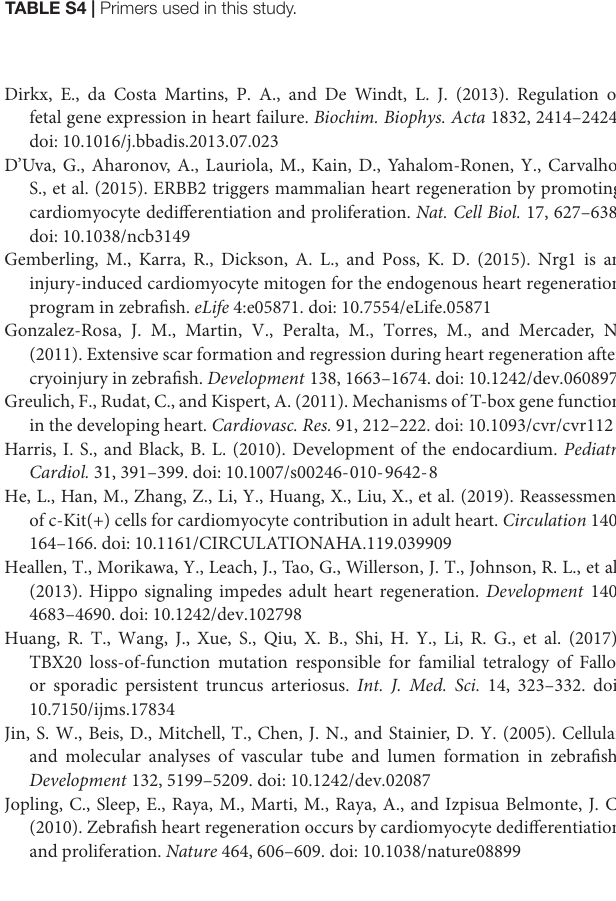
(A,B) , gata4 (C,D) , gata5 (E,F) and hand2 (G,H) in the adult injured Tg ( TRE3G:tbx20 ) and Tg ( TRE3G:tbx20 CMOE ) zebrafish ventricles after DOX-treatment at 7 dpa. Dotted lines demarcate amputation plane. Sale bar: 100 µ m. (I) Statistical analyses of qPCR for gata4 , gata5 and hand2 in the injured ventricle apices from Tg ( TRE3G:tbx20 ) and Tg ( TRE3G:tbx20 CMOE ) zebrafish at 7 dpa. Data represent three biological replicates. Mean ± SEM, ∗ p < 0.05, ∗∗∗ p < 0.001. FIGURE S8 | Expression profile of different BMP ligands in injured hearts. (A) Heat map showing fold changes for transcripts of BMP signaling ligands in DOX-treated Tg ( TRE3G:tbx20 ) and Tg ( TRE3G:tbx20 CMOE ) at 7 dpa detected by RNA-seq. (B–G) ISH analyses for bmp3 (F,G) , bmp6 (B,C) and bmp10 (D,E) on heart sections from DOX-treated Tg ( TRE3G:tbx20 ) or Tg ( TRE3G:tbx20 CMOE ) zebrafish at 7 dpa and 5 dpci. Red arrowheads in (B,C) indicate endocardium with bmp6 signal. Dotted lines demarcate amputation plane. Sale bar: 100 µ m. FIGURE S9 | id1 and id2b expression are not altered in injured control hearts after BMP inhibitors treatment. (A–F) Representative ISH images showing expression pattern of id1 (A–C) and id2b (D–F) in DOX treated Tg ( TRE3G:tbx20 ) fish at 5 dpci after vehicle or inhibitors treatment. Dotted lines demarcate amputation plane. Scale bar: 100 µ m.